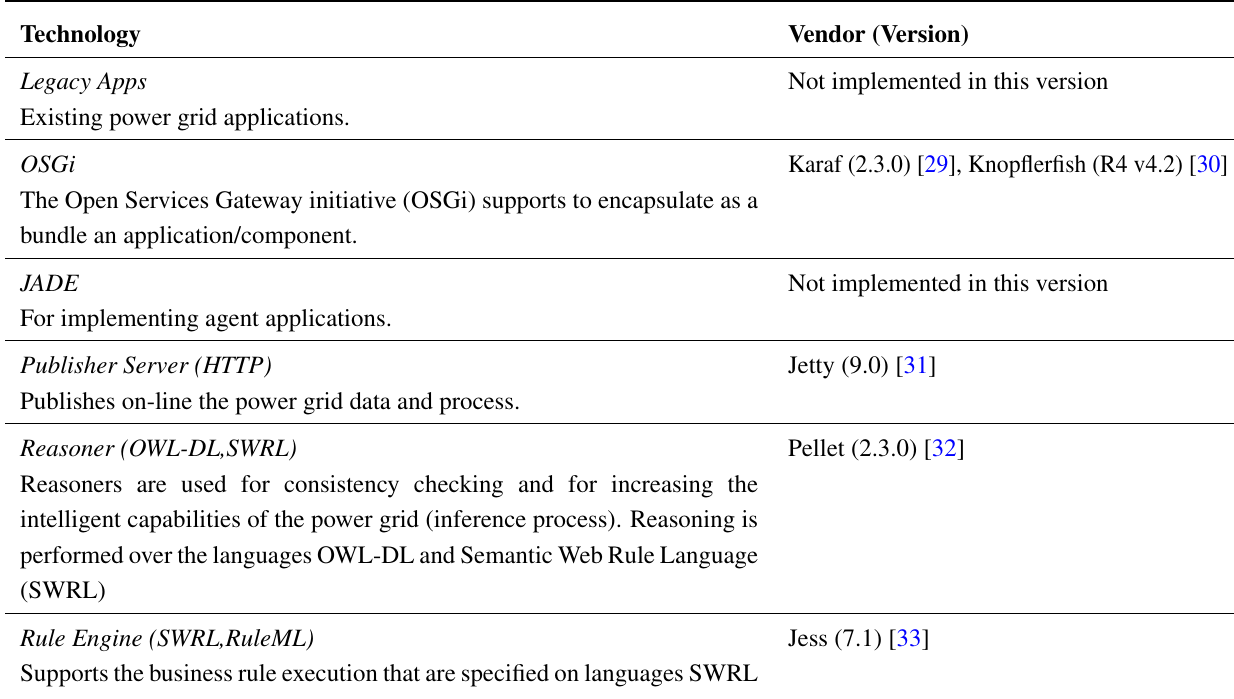
Table 1. Technology specification for the PGDIN implementation (Version